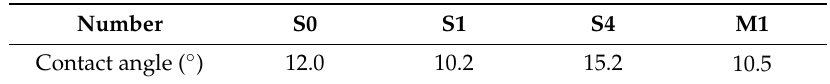
Figure 5. Optical image showing the contact angle measurement between the 9Cr18 stainless steel specimen S0 and lubricant oil. Table 3. The measured contact angles between different 9Cr18 stainless steel and M50 bearing steel specimens and lubricant oil.